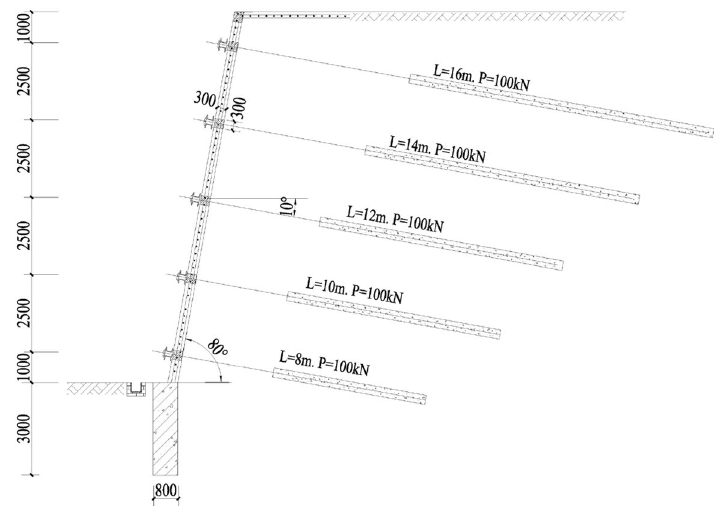
Figure 3. Design result of slope support.